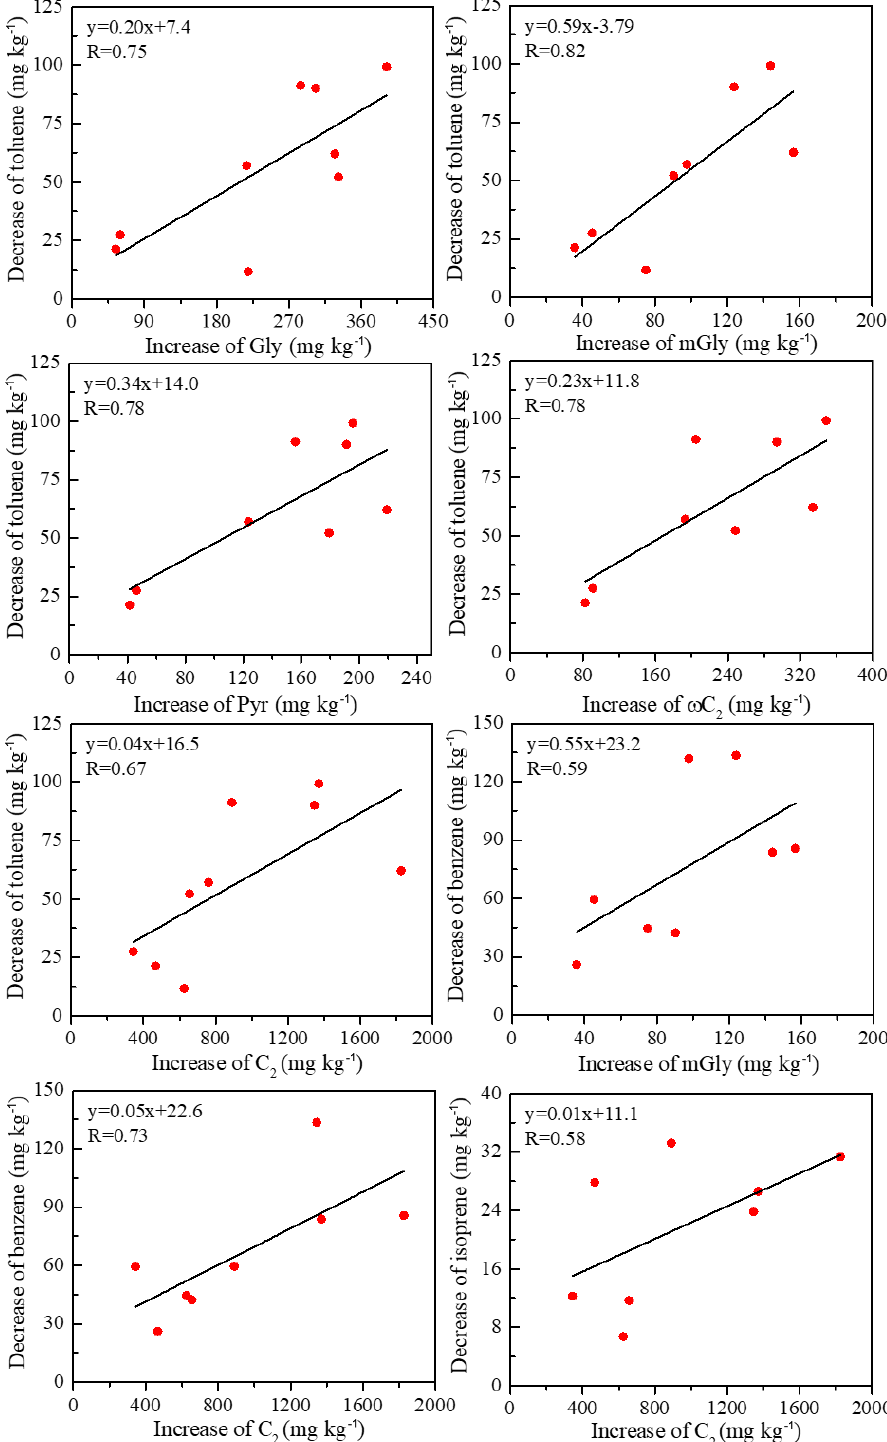
Figure 5. Regressions between the decreases of specific VOCs (toluene, benzene and isoprene) and increases of C 2 and its intermediates, methylglyoxal (mGly), glyoxal, (Gly), pyruvic acid (Pyr) and glyoxylic ( ω C 2 ).